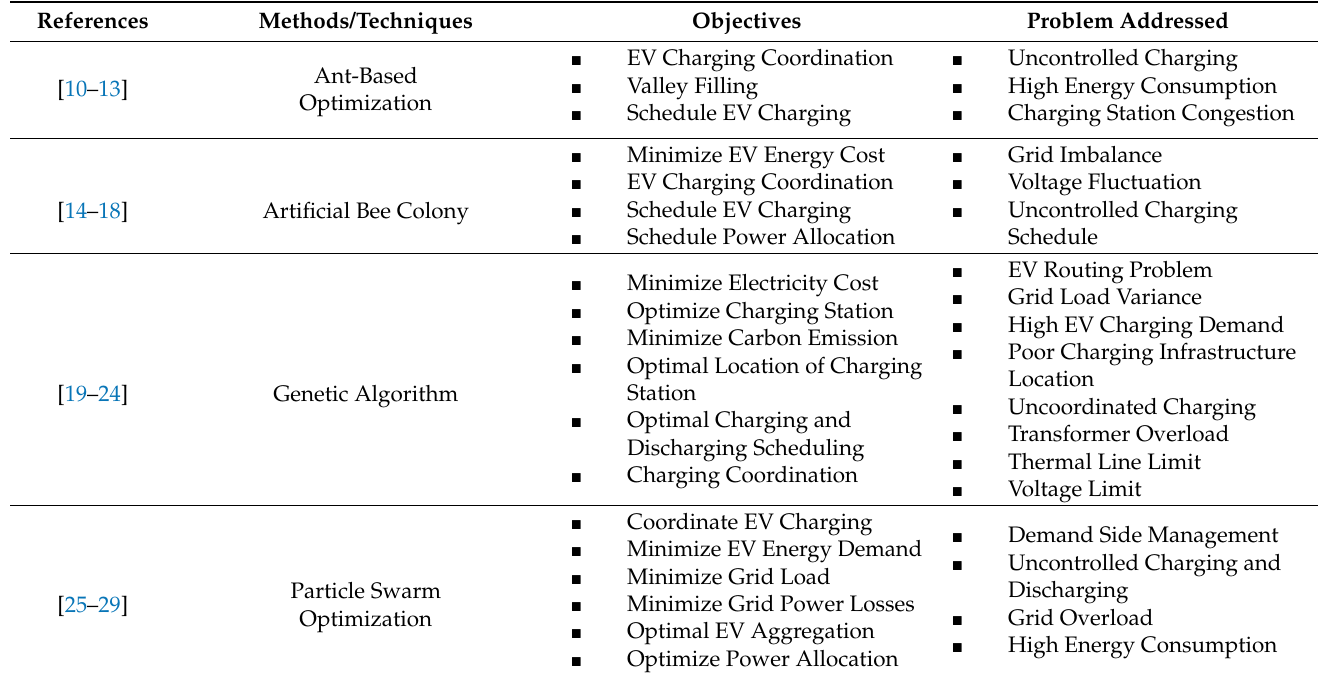
Table 3. 1 Selected control methods applied to EV charging on the